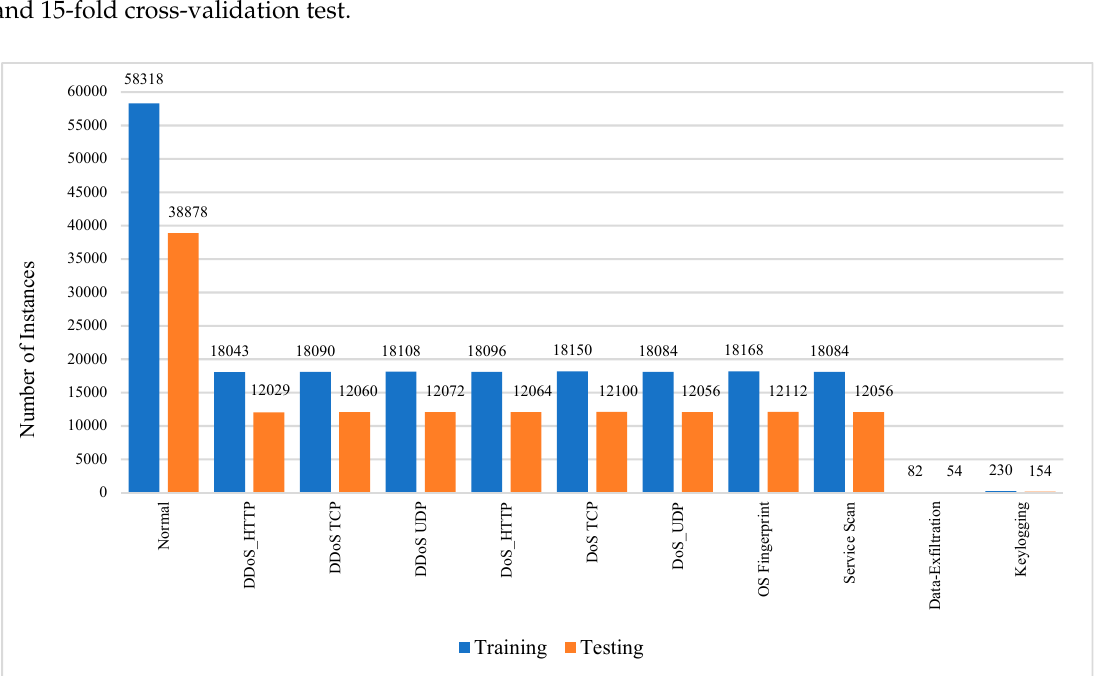
Table 5. Contingency Matrix Label.